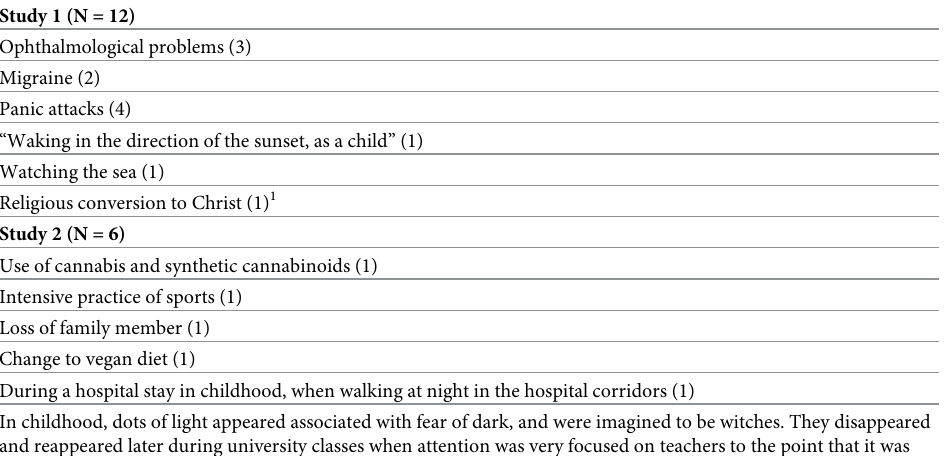
Table 7. Events associated with the first appearance of visual snow: Numbers of participants reporting a particu- lar event are indicated in